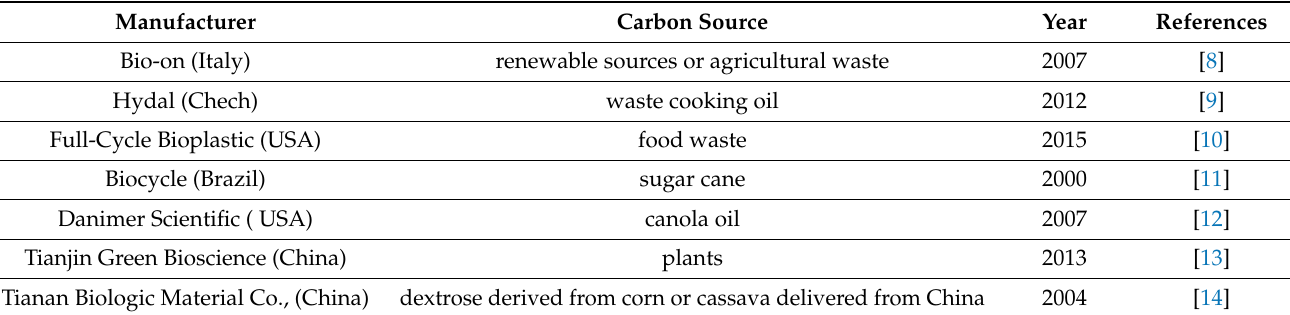
Table 1. Manufacturers producing PHAs from renewable